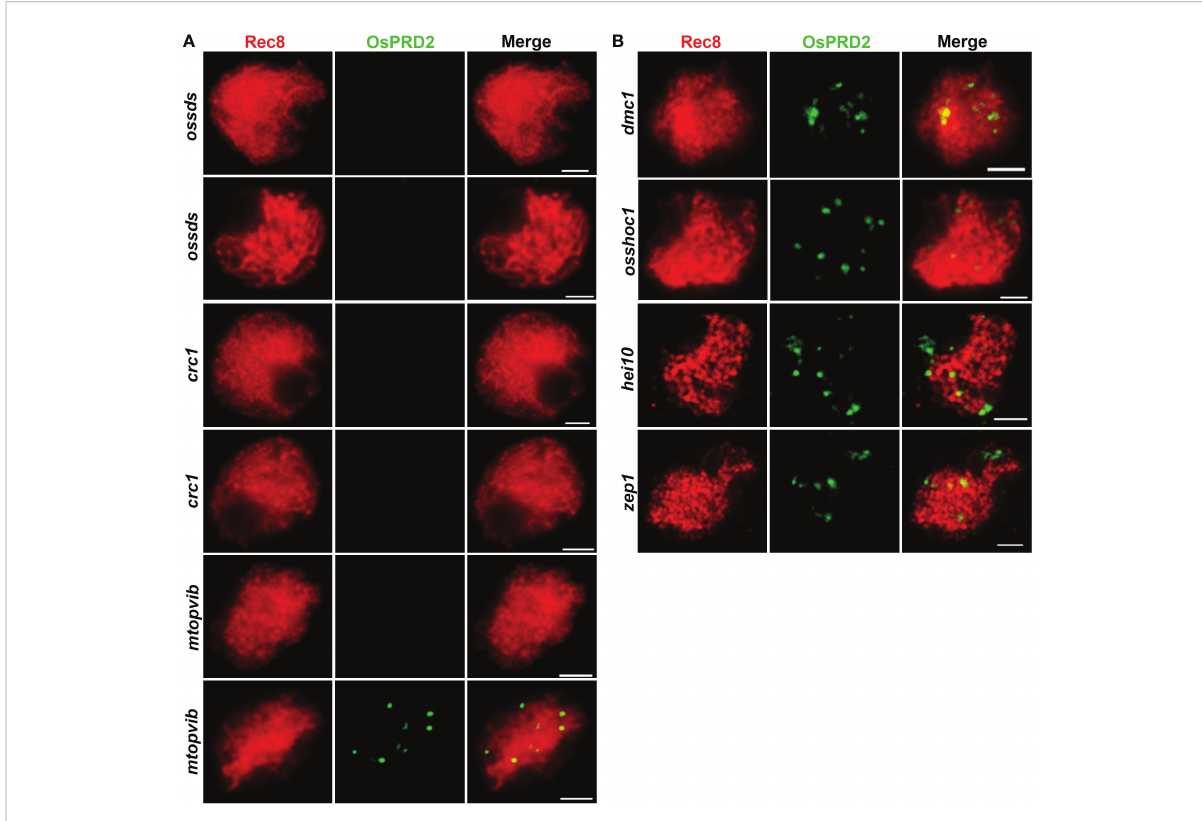
FIGURE 8 PRD2 localization is dependent on DSB formation but synapsis and recombination. (A) is PRD2 localization in mutants defective in DSB formation; (B) is PRD2 localization in mutants of key genes involved in synapsis and recombination. Bar=2 m m. (B) is informative. PRD2 is